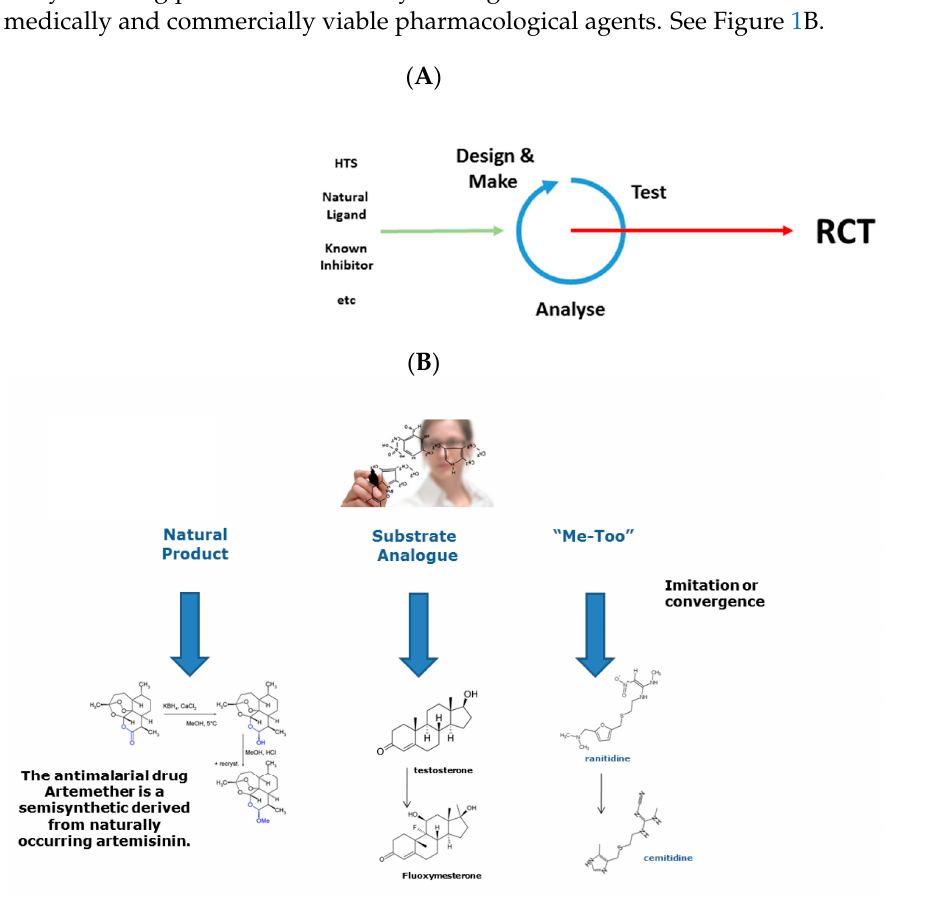
Figure 1. ( A ) the drug discovery paradigm; ( B ) synthetic approaches.